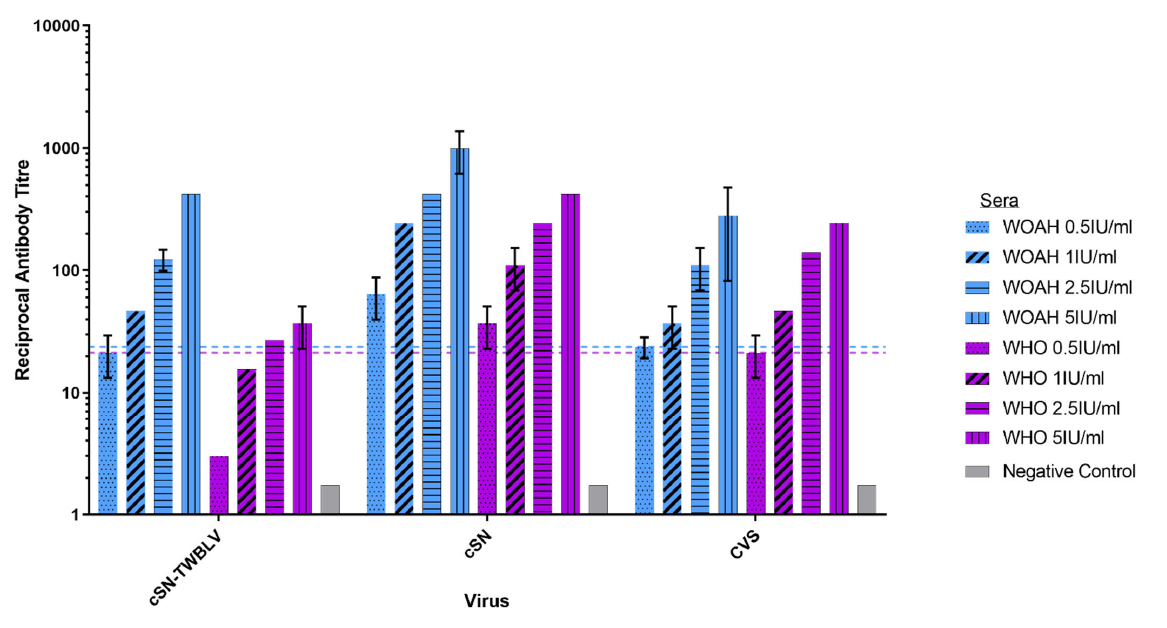
Figure 2. Neutralisation profiles of cSN-TWBLV, cSN and CVS against WOAH and WHO standard sera using a modified fluorescent antibody virus neutralisation (mFAVN) test. The test was performed in triplicate and as three independent experiments where the mean and standard deviation of the results were plotted on a logarithmic scale. The 0.5 IU/mL neutralisation cut-off is dictated by the serological standards against CVS (indicated by the coloured dashed lines–WOAH = blue, WHO = purple).